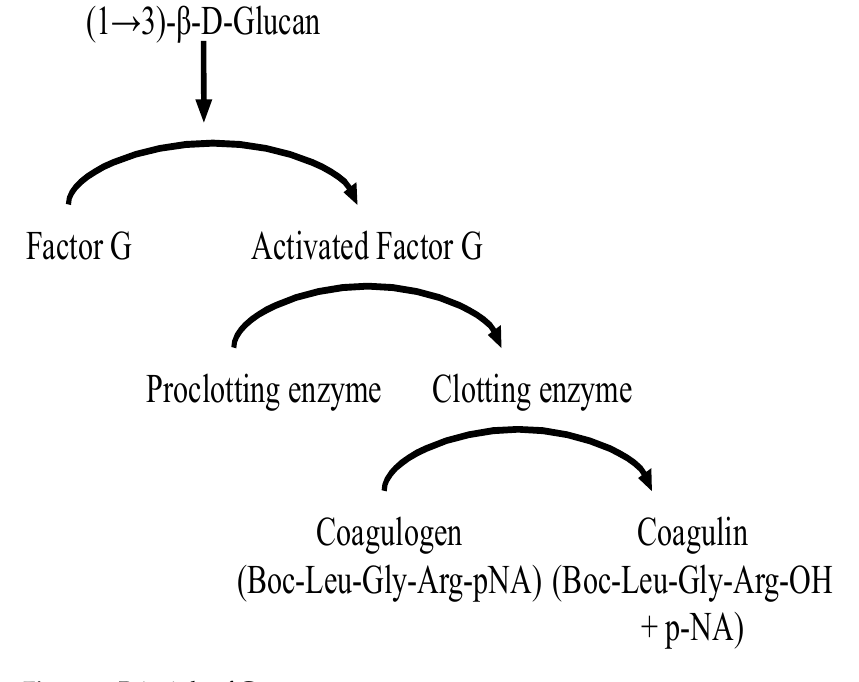
Figure 1. Principle of G test.